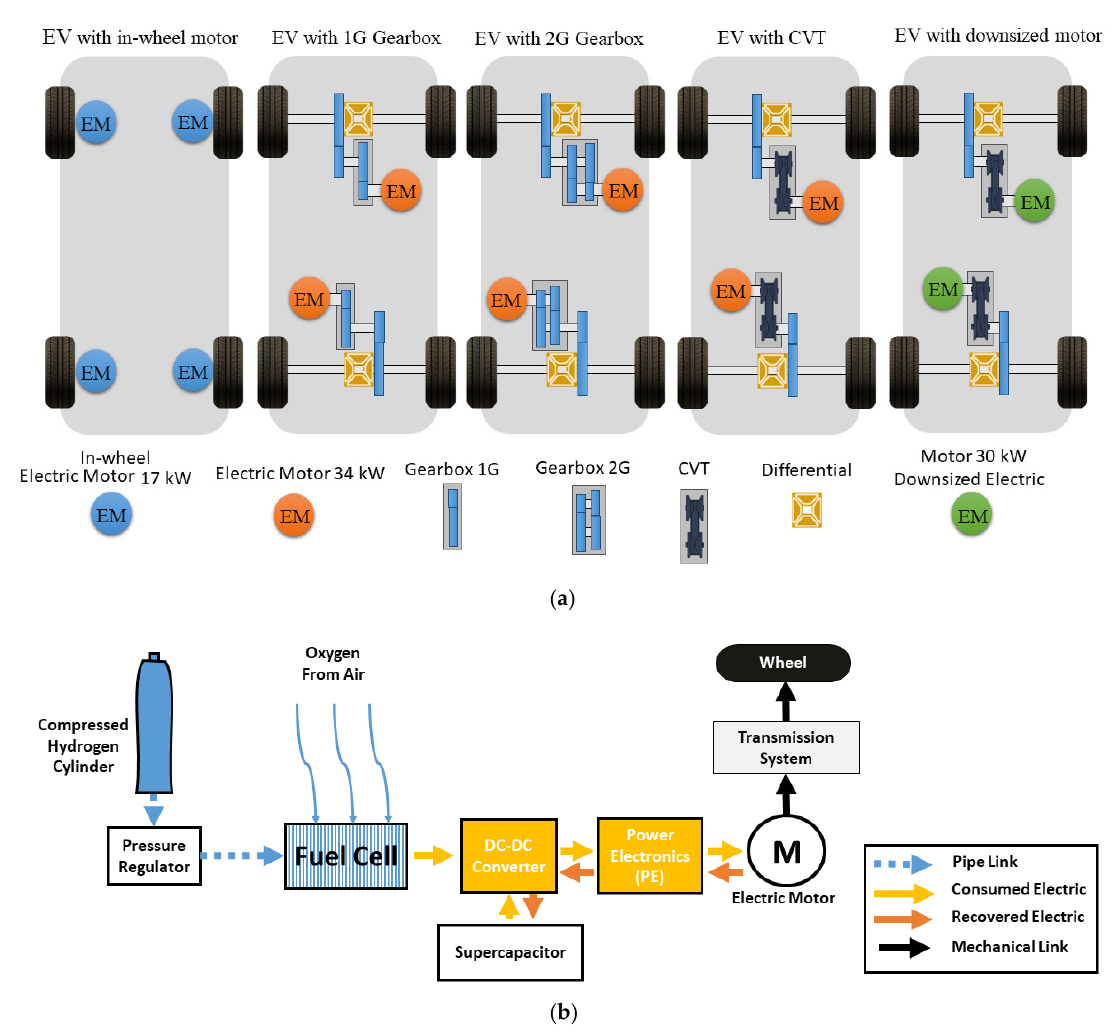
Figure 2. ( a ) Vehicle architectures electric vehicles (EV); ( b ) energy supply diagram of hydrogen fuel-cell electric vehi- cle